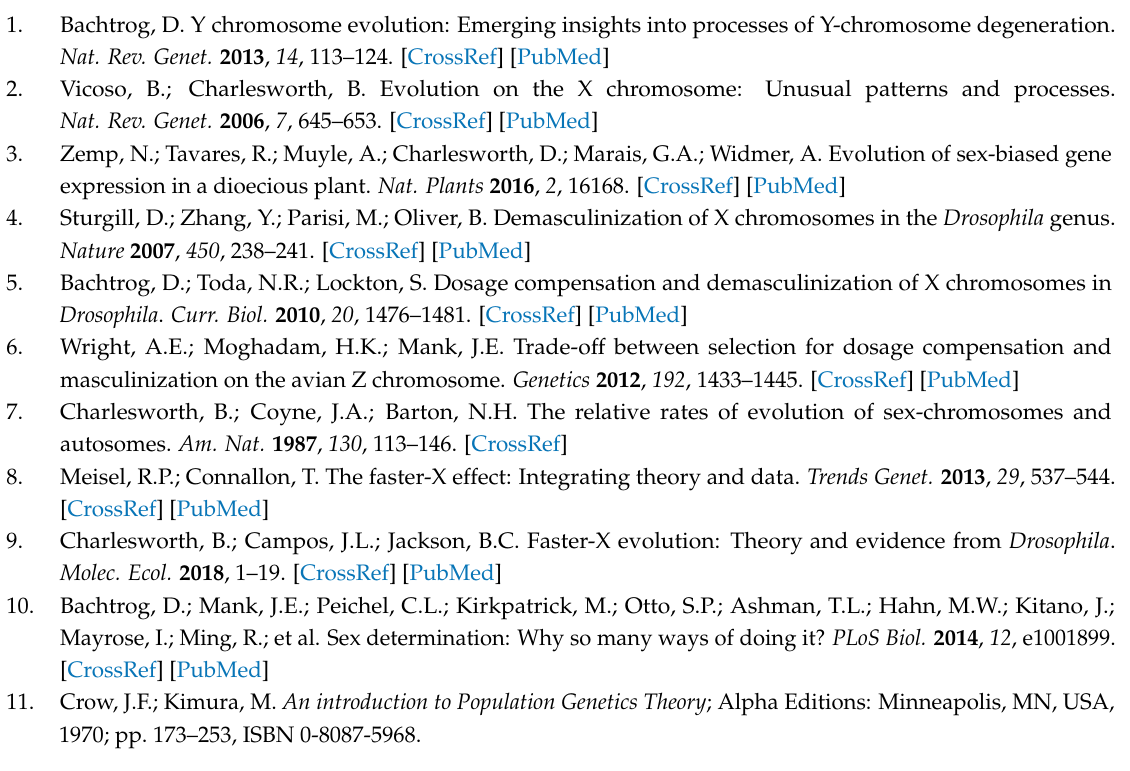
Figure S1: Genetic diversity at silent sites of X-linked and autosomal genes, Table S1: The numbers of preferred (P) and un-preferred (U) codon